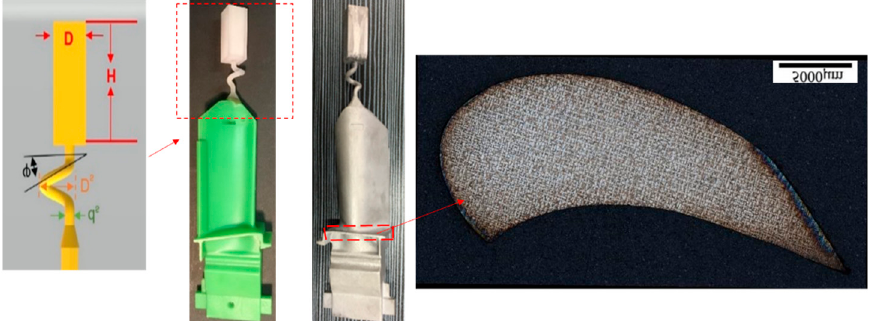
Figure 10. Flow-process diagram of the single-crystal (SX) turbine blade investment casting with a new spiral selector based on optimized 2D selector parameters.